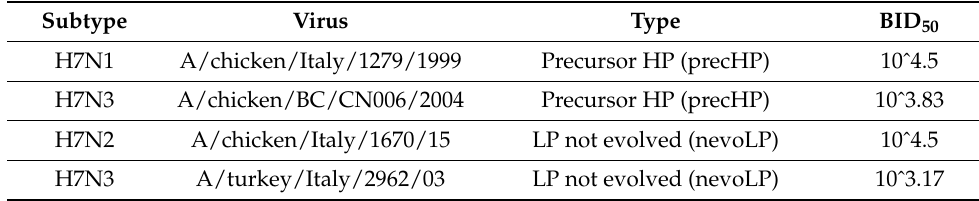
Table 1. Viruses used and infectious dose